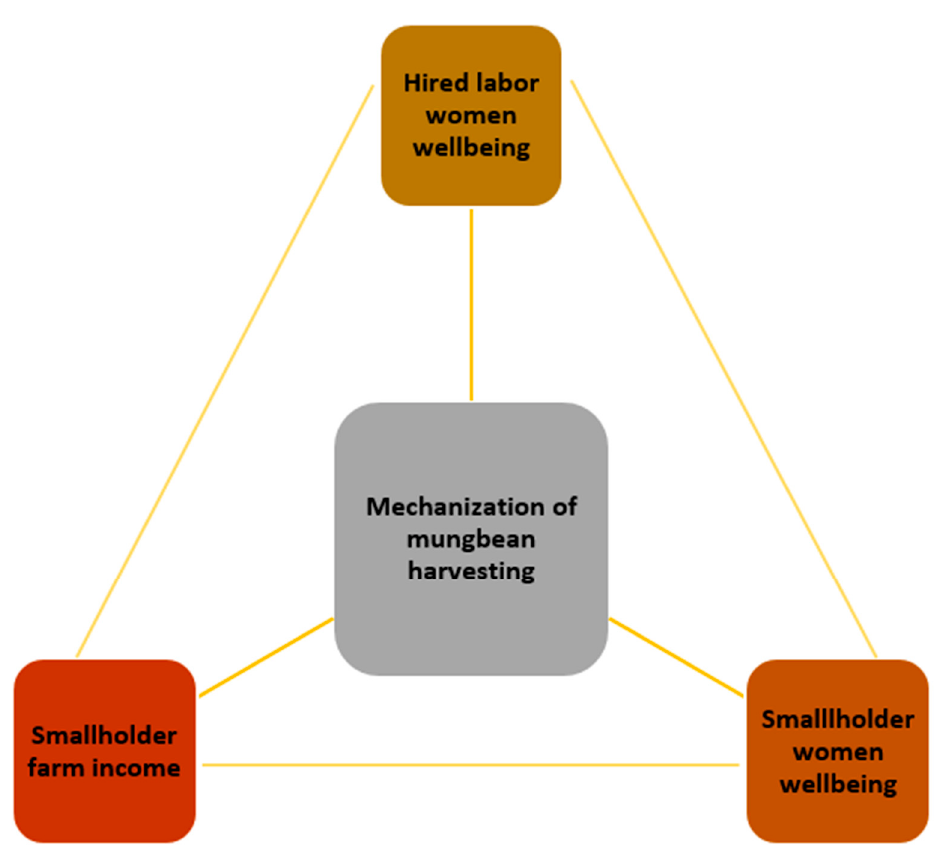
Figure 1. Potential gendered tradeoffs associated with mechanizing mungbean harvesting.